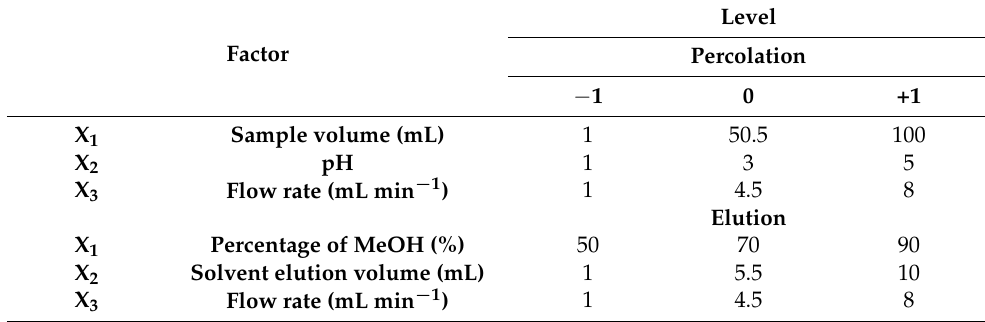
Table 1. Investigated variables and their levels studied in the BBD of percolation and elution steps.